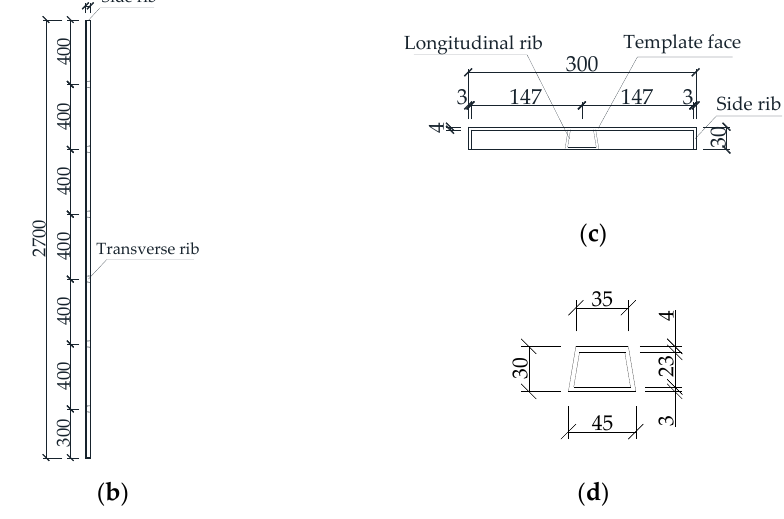
Figure 6. Formwork: ( a ) front view; ( b ) side view; ( c ) normal cross-section; ( d ) rib section. For the vertical joint designed with a width of 500 mm, as presented in Figure 7, the joint formwork was spliced by two unitary formworks with a lap length of 50 mm on each side of the wall. To ensure that the entirety of formwork was integrally subjected to the lateral pressure of SCC, back purlin braces and pair bolts were used to bind the uni- tary formworks together and fix them to the precast walls. The back purlin braces and bolts were steel. The braces were hollow with a section of 40 mm × 60 mm and a shell thickness of 3 mm. The braces were placed on the back of the formwork at a height from the bottom of 200 mm, 800 mm, 1450 mm, and 2250 mm. The diameter of the bolts was 12 mm.